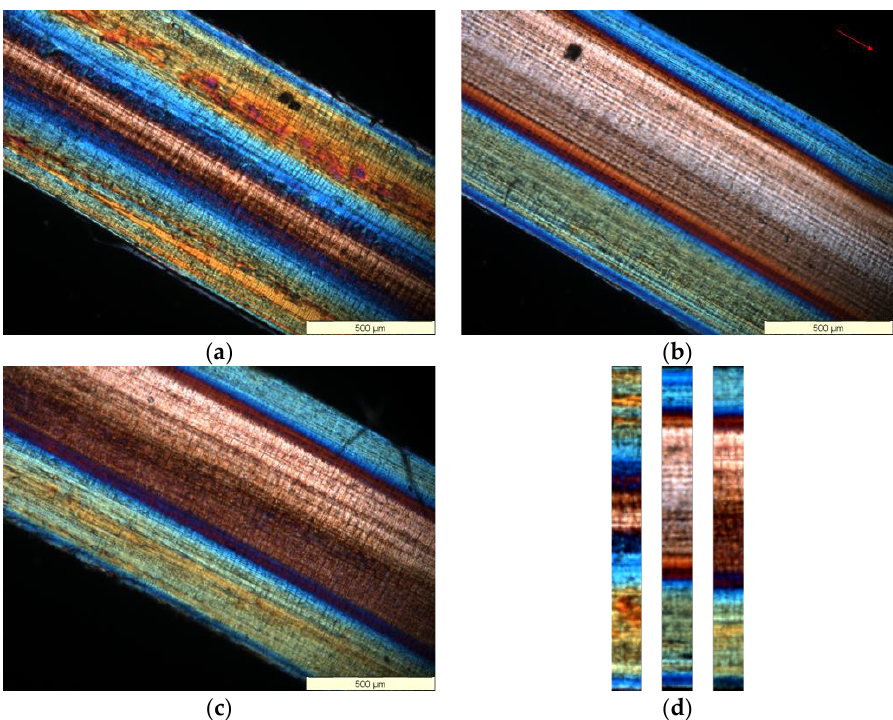
Figure 4. Optical micrographs acquired in position P2 for three cases: ( a ) conventional injection molding condition, ( b ) 40 W heating power, and ( c ) 68 W heating power. ( d ) Comparison among the three conditions.